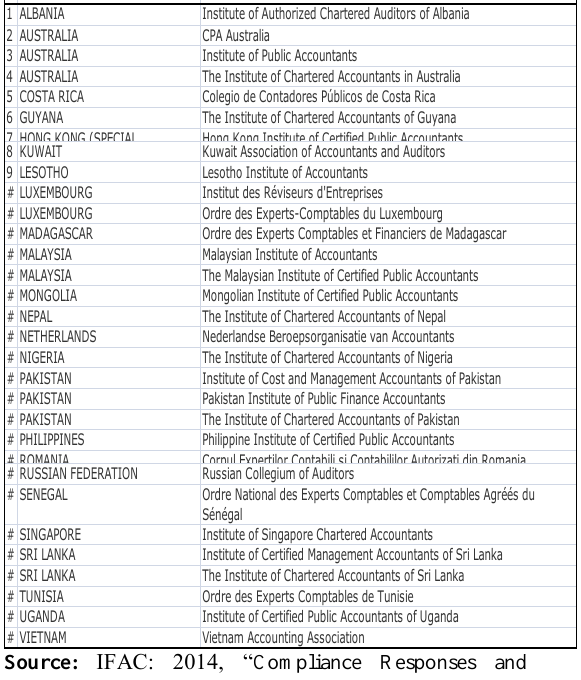
Table 2: Accounting Organizations that Apply the IFAC Code of Ethics with Slight Modifications COUNTRY